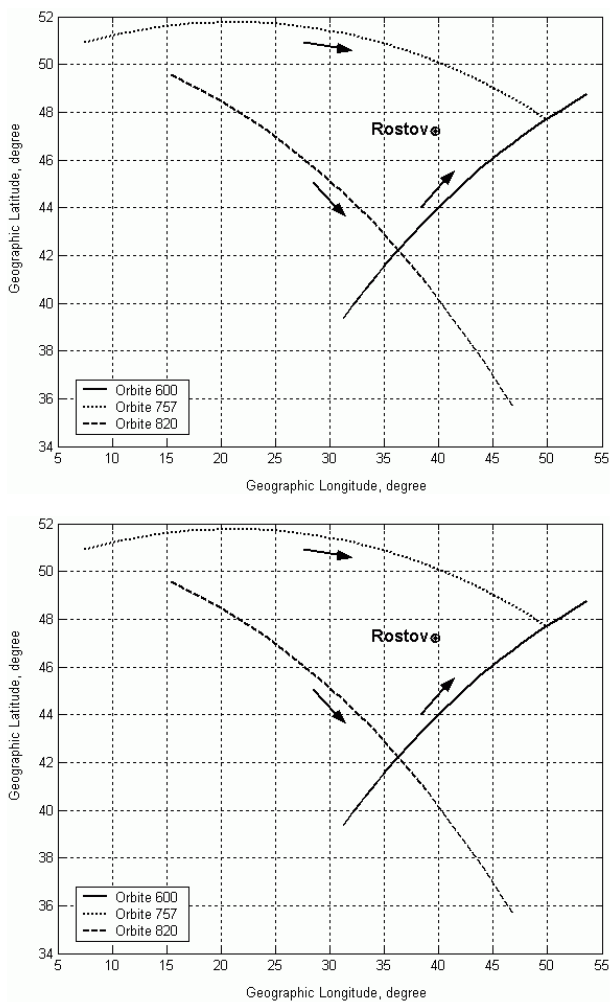
Fig. 1. Geographical and geomagnetic co-ordinates of the MIR sta- tion for three sample